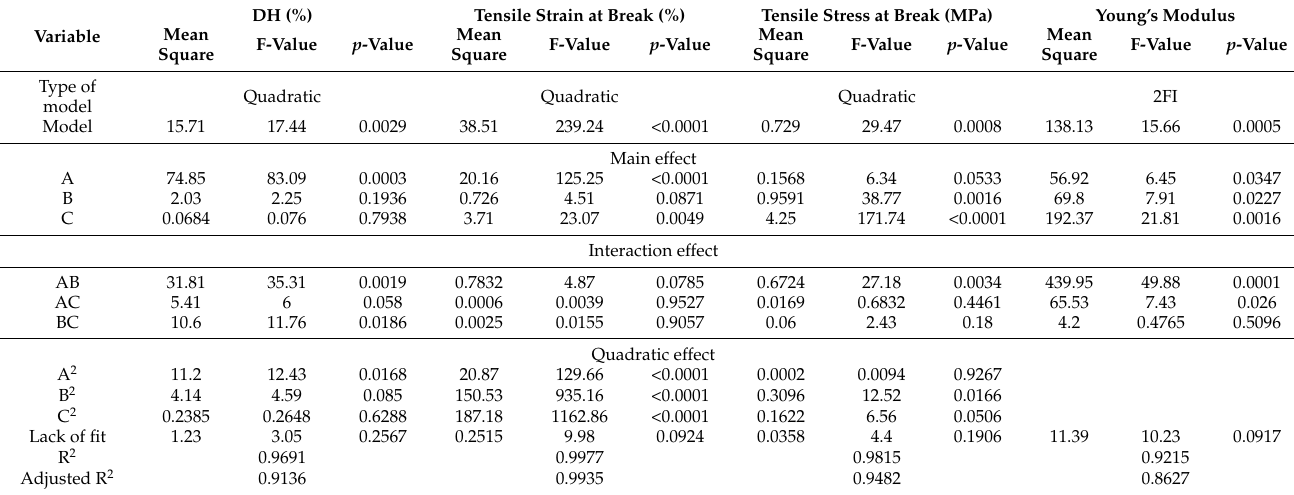
Table 4. ANOVA of the regression coefficients of the fitted quadratic equations for the